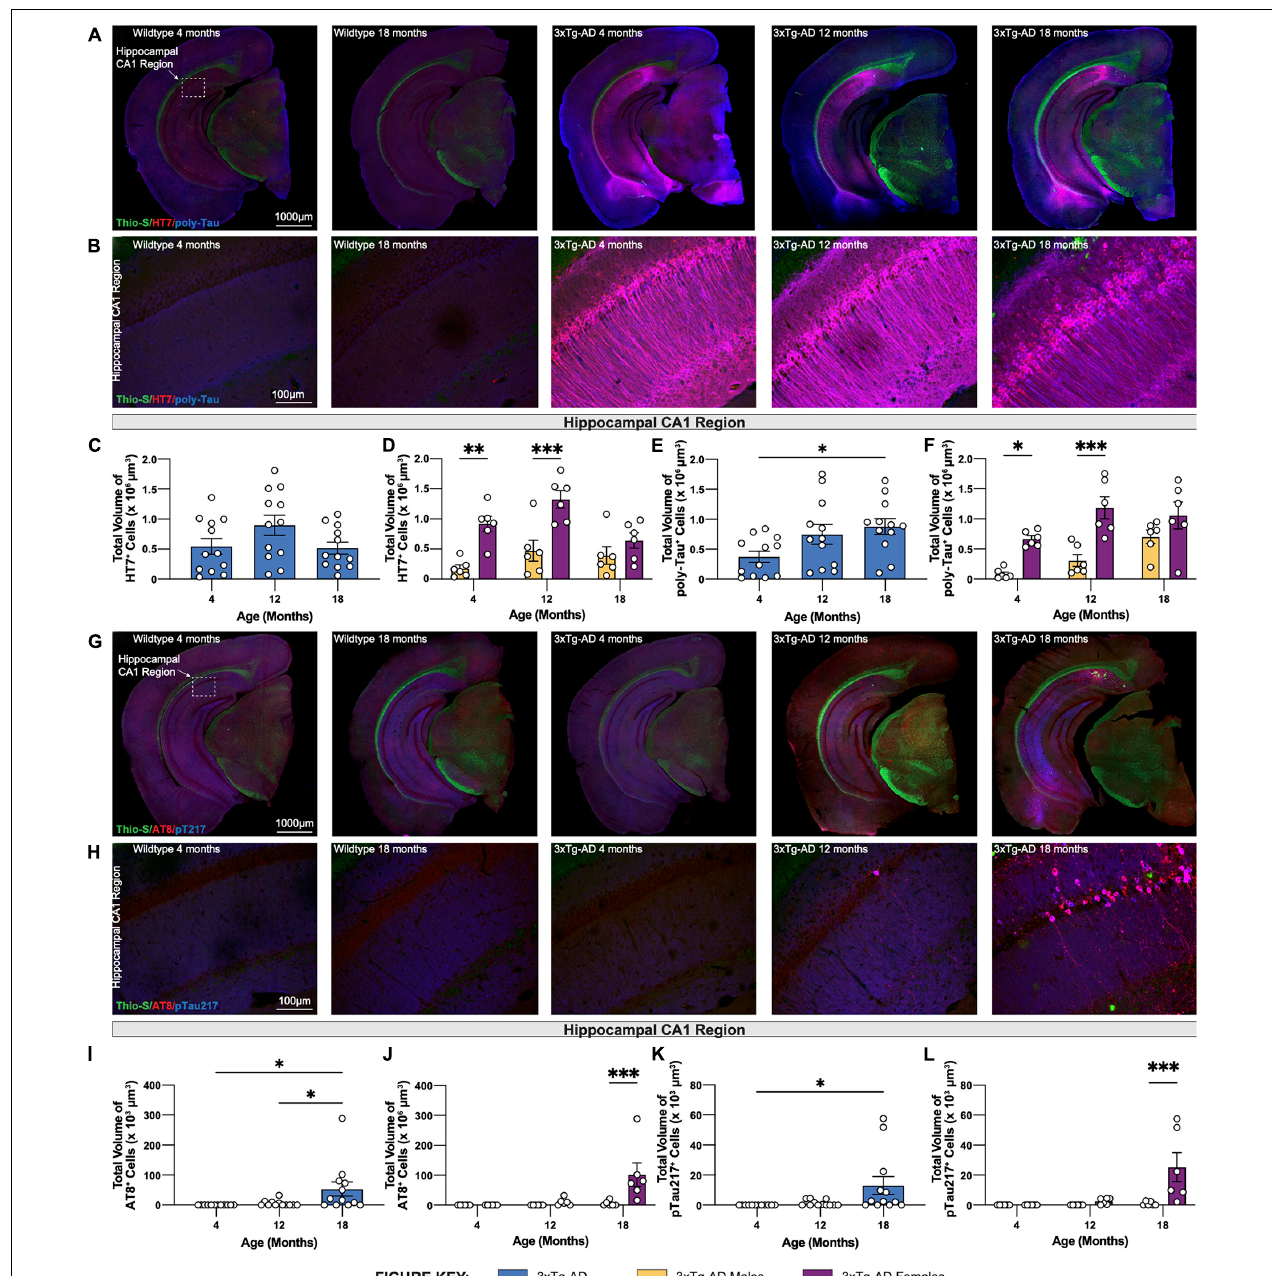
FIGURE 4 | Phosphorylated tau increases in volume in 18-month-old female 3xTg-AD mice. Accumulation of human tau was assessed by immunostaining using HT7 and poly-tau antibody, while phosphorylated tau was assessed using AT8 and phospho-Tau Thr 217 antibody, respectively. (A) Representative stitched brain hemispheres of WT and 3xTg-AD mice stained with Thio-S/HT7/poly-tau at 4- and 18-month and 4-, 12-, and 18-month timepoints, respectively. (B) Representative confocal images of HT7 + and poly-tau + cells in the hippocampal CA1 regions of WT and 3xTg-AD mice across respective timepoints. (C,D) HT7 immunostaining reveals age-related changes in total volume of HT7 + cells in 3xTgAD mice between sexes. (E,F) Poly-tau immunostaining reveals age-related changes in total volume of poly-tau + cells in 3xTg-AD mice between sexes. (G) Representative stitched brain hemispheres of WT and 3xTg-AD mice stained with Thio-S/AT8/pT217 at 4- and 18-month and 4-, 12-, and 18-month timepoints, respectively. (H) Representative confocal images of AT8 + and Thr217 + cells in the hippocampal CA1 regions of WT and 3xTg-AD mice across respective timepoints. (I,J) AT8 immunostaining reveals age-related changes in total volume of AT8 + cells in 3xTg-AD mice between sexes. (K,L) Thr217 immunostaining reveals age-related changes in total volume of Thr217 + cells in 3xTg-AD mice between sexes. n = 5–6 mice per genotype/age/sex. Data are represented as mean ± SEM. ∗ p ≤ 0.05, ** p ≤ 0.01, ∗∗∗ p ≤ 0.001.